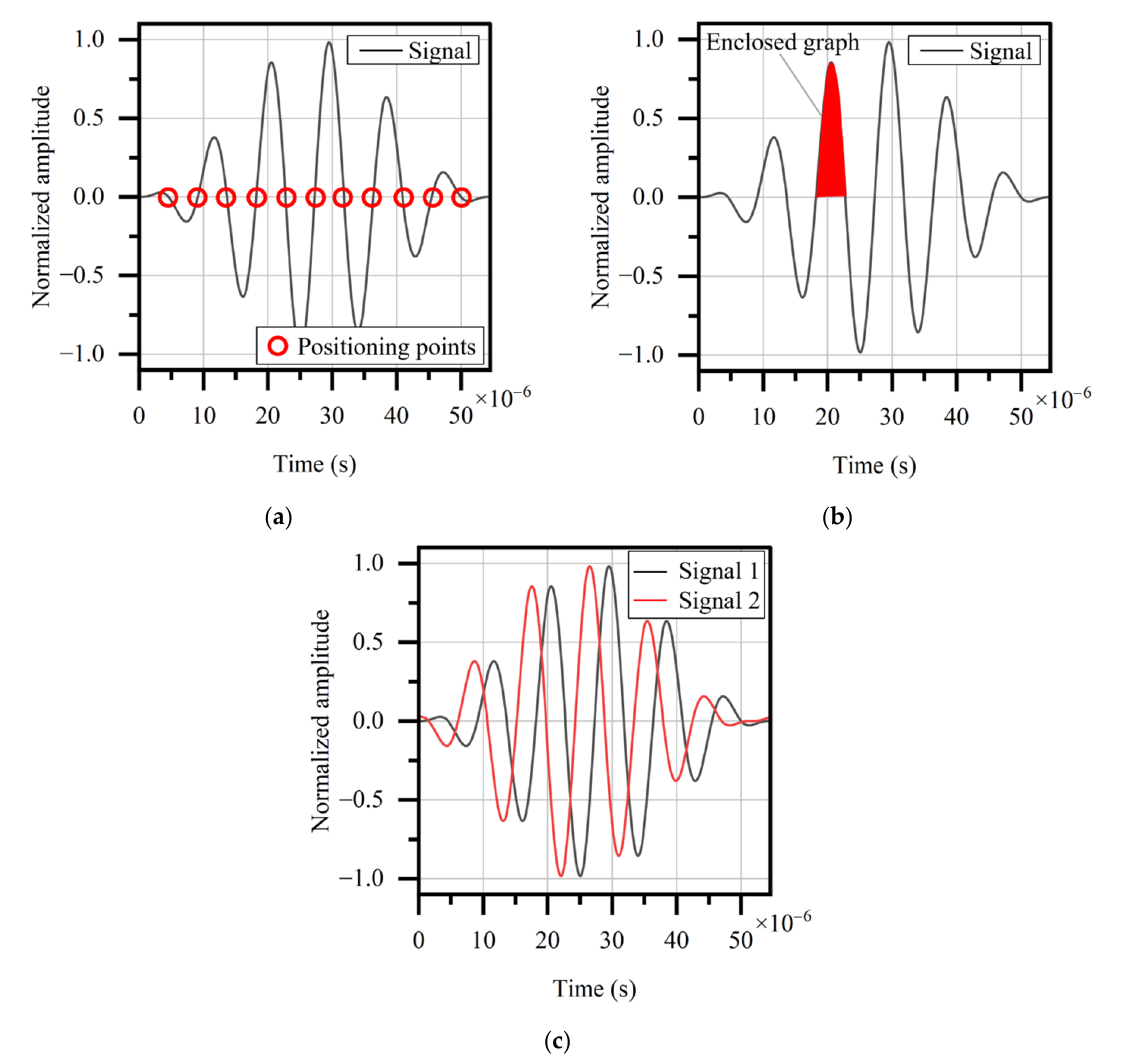
Figure 6. Conceptual illustration of three positioning methods: ( a ) zero-point method; ( b ) graph centroid method; ( c ) cross-correlation method.